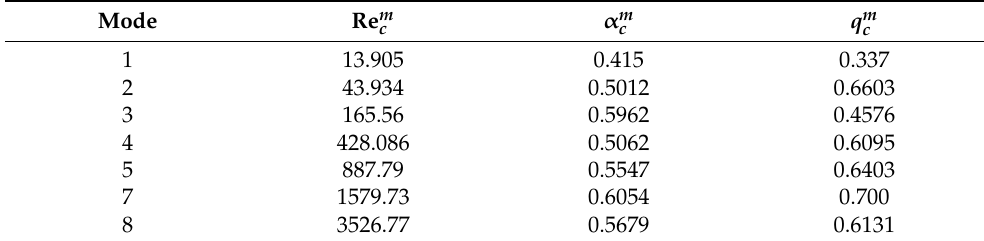
Table 2. Critical values of unstable